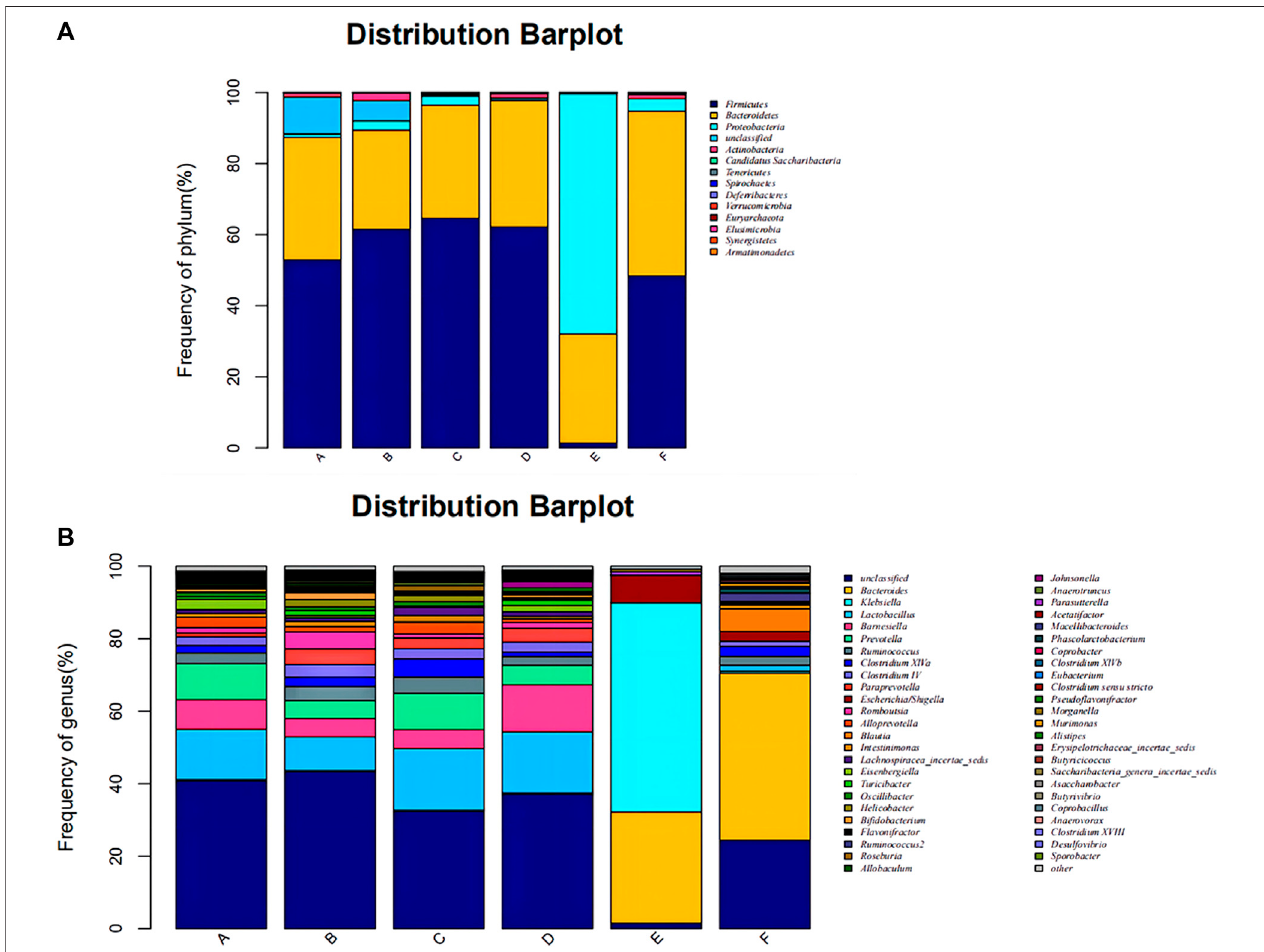
FIGURE 2 | Composition and distribution of the intestinal fl ora in each group at the phylum and genus level. Composition and distribution of the intestinal fl ora in eachgroupat (A) thephylumleveland (B) thegenuslevel.Theabscissaisarrangedaccordingtothesamplename,eachbarchartrepresentsasample,andthetaxonis distinguished by color. The ordinate represents the relative abundance of each taxon, and the longer the column, the higher the phase abundance of the taxon in the corresponding sample. Control group before modeling (Group A), antibiotic treated for 3 days group before modeling (Group B), the antibiotic treated for 3 days group before modeling (Group C), Control group after modeling (Group D), the antibiotic treated for 3 days group after modeling (Group E), and the antibiotic treated for 7 days group after modeling (Group F).